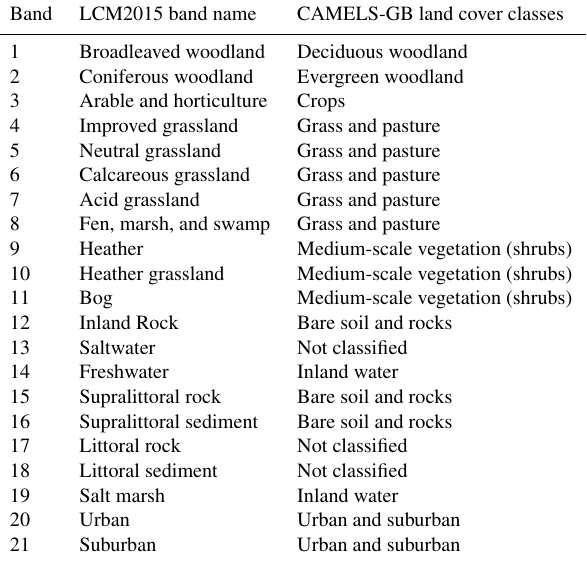
Table B1. Band ID and name from Land Cover Map (LCM) 2015 and corresponding land cover classes used in